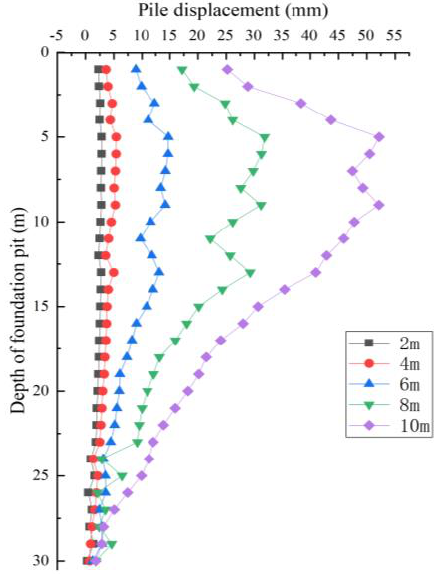
Figure 7. Horizontal displacement of rear straight pile.